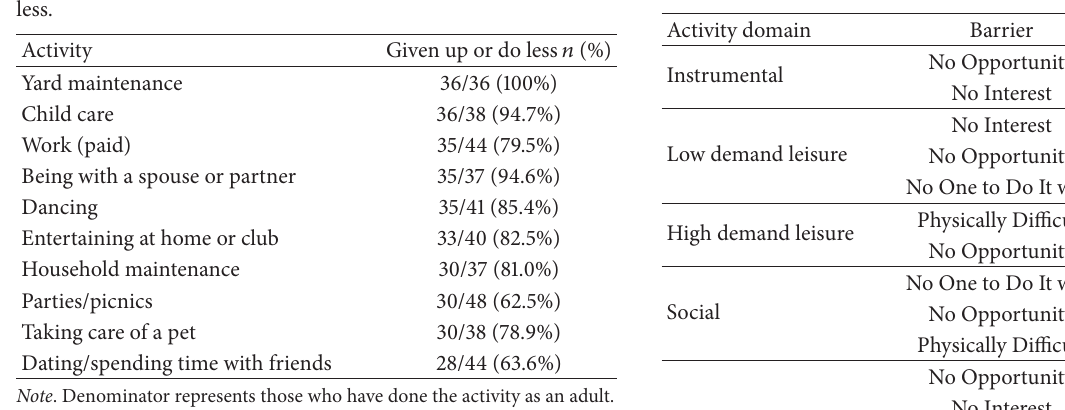
Table 3: Most common barriers by activity domain ( 𝑛 = 51